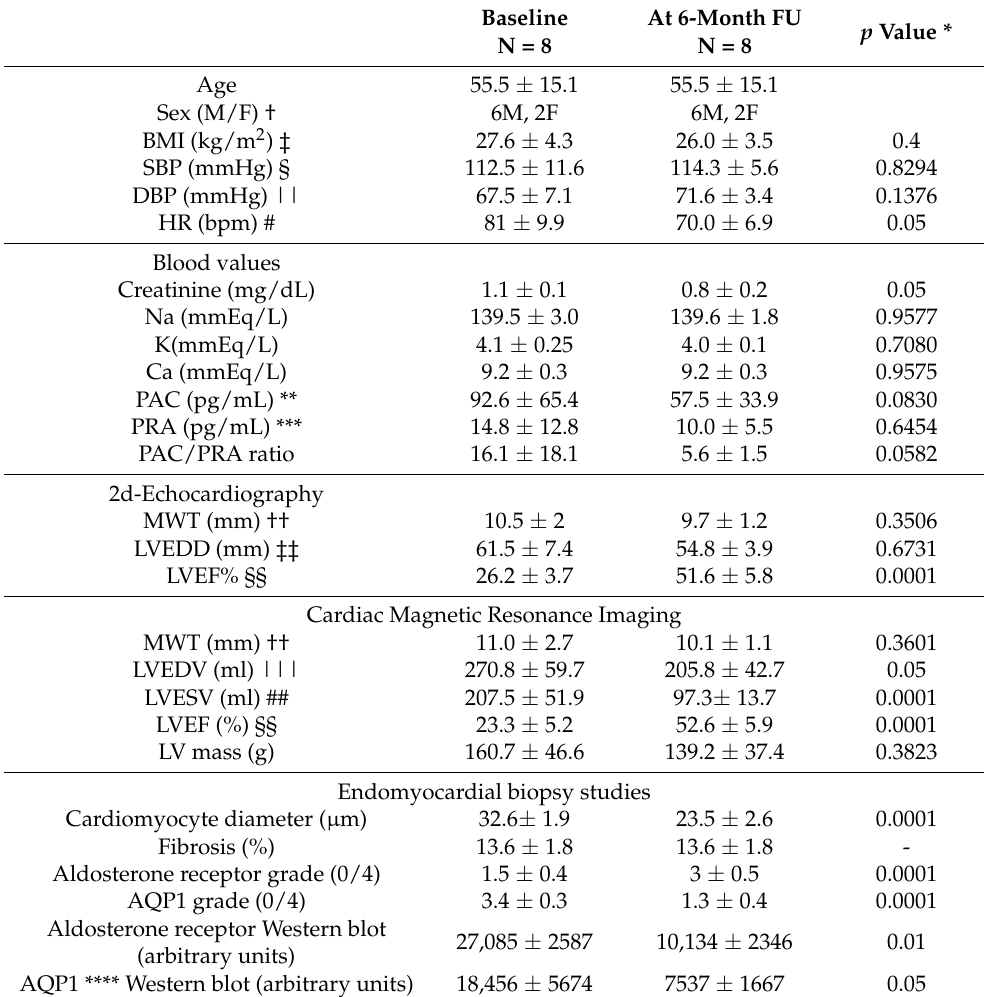
Table 2. Comparison of biochemical, clinical, and endomyocardial biopsy data in 8 patients with heart failure: baseline and at 6-month follow